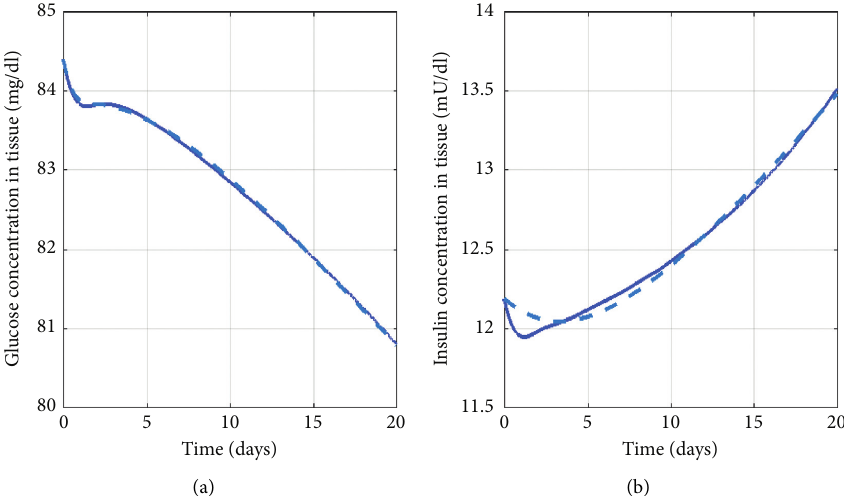
Figure 2: Trends of glucose (a) and insulin (b) concentrations in tissues compared with those of clinical data. The observed data (dashed) and the solution of our mathematical model (solid).